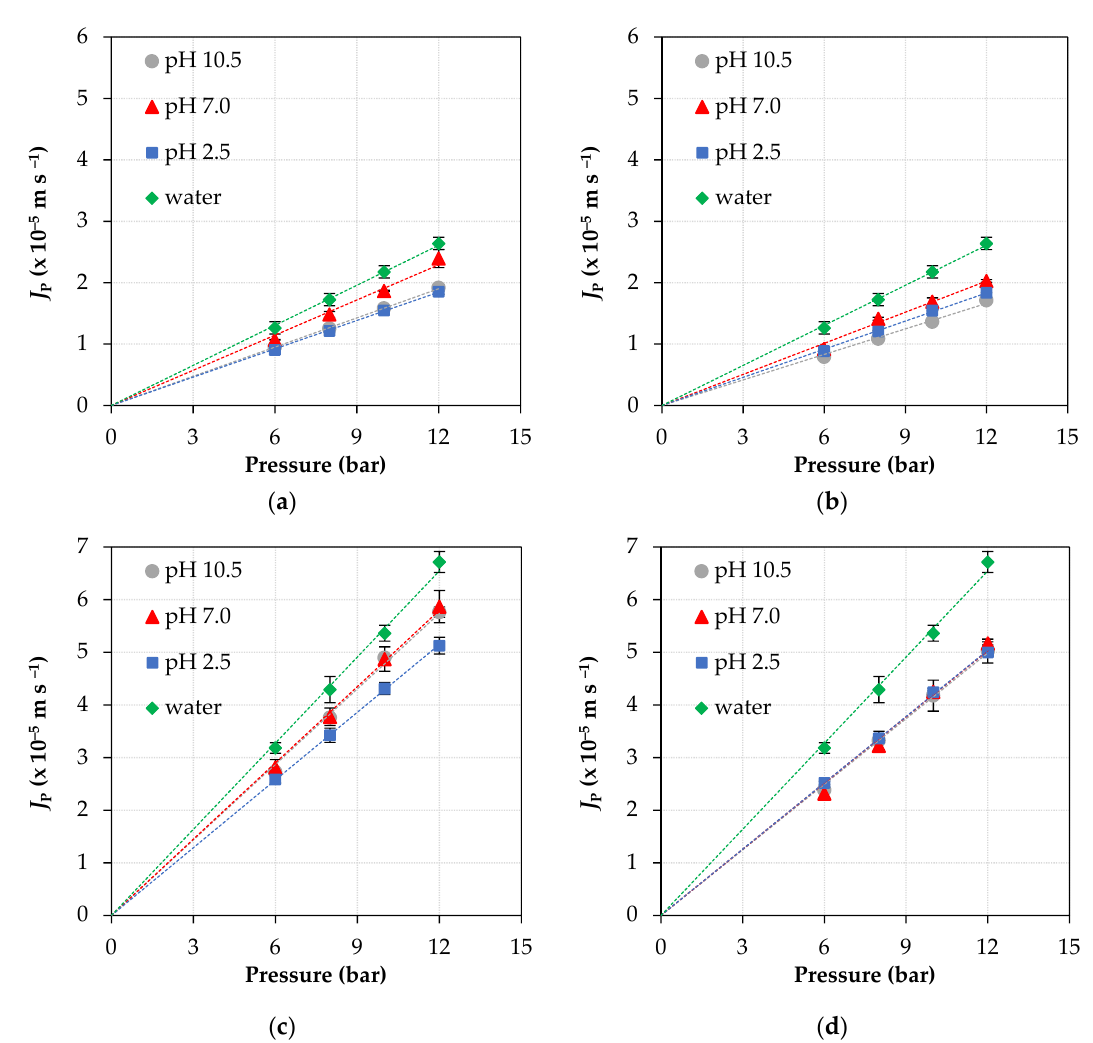
Figure 2. Permeate fluxes as a function of pressure, at three pH conditions, with NF90 (top) and NF270 (bottom) membranes: ( a ), ( c ) feed solution with 8 mg L − 1 ATN; ( b ), ( d ) feed solution with 16 mg L − 1 ATN.